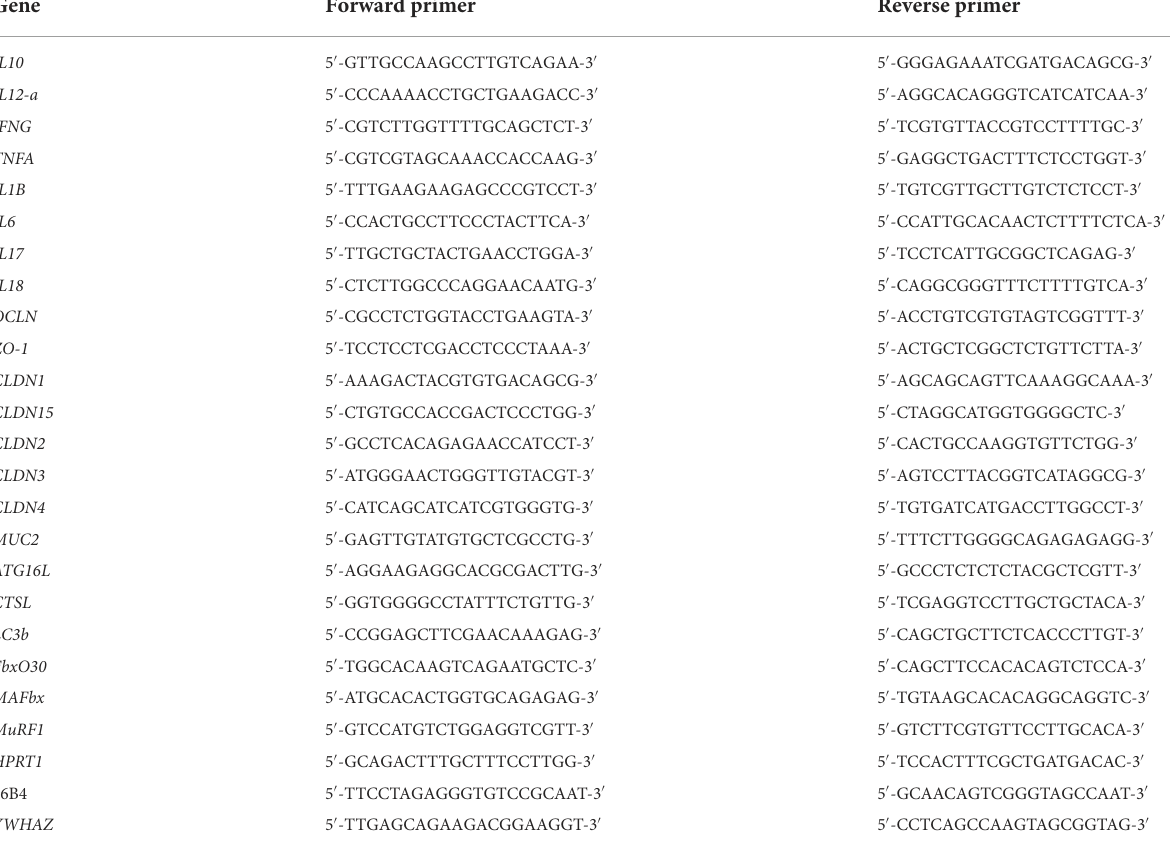
TABLE 1 Primers sequences used for qRT-PCR in the colon and the muscle. Gene